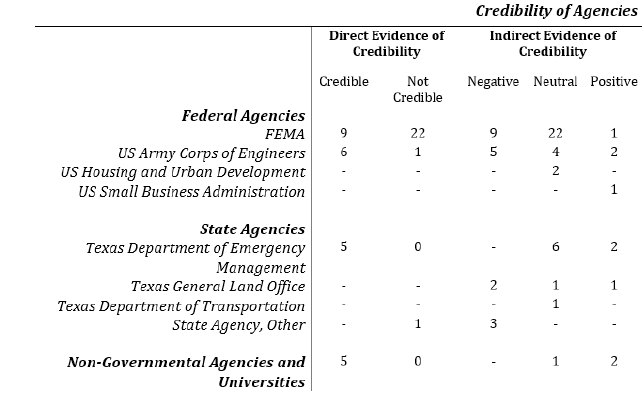
Table 2: Frequency of mentions of credibility for federal, state, and local agencies